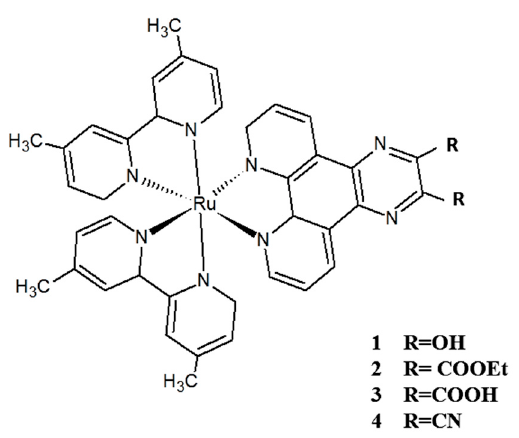
Figure 13. General structure of [Ru(dmbpy) 2 R 2 ppl] 2+ complexes.